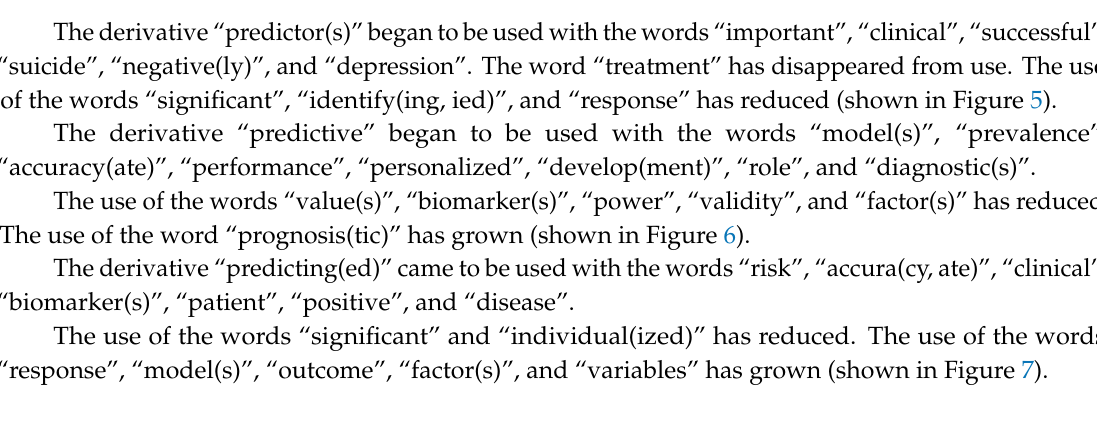
Figure 7. The frequency of occurrence of terms in the vicinity of the derivative “predicting(ed)” over the past decade.